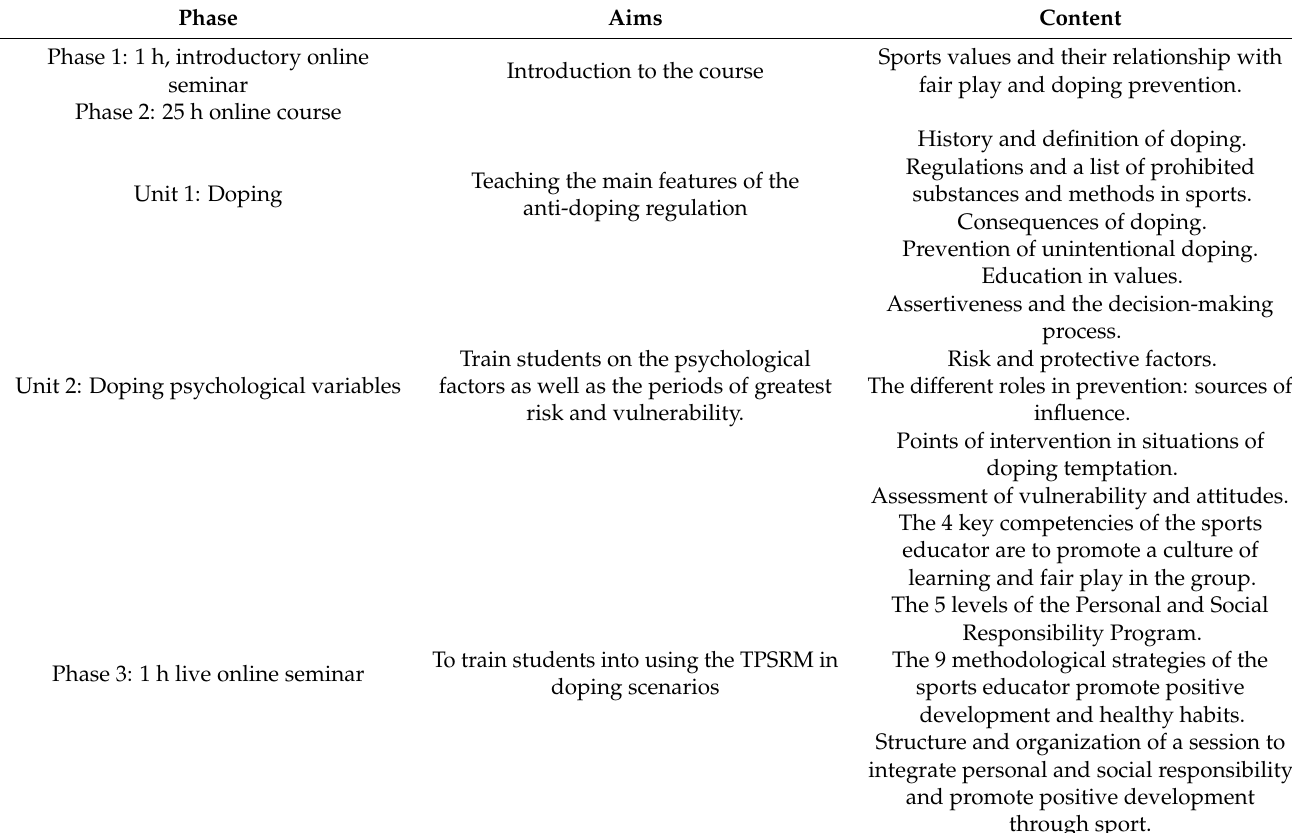
Table 1. Participants and characteristics of a Vive Sin Trampas (Live Without Cheating)